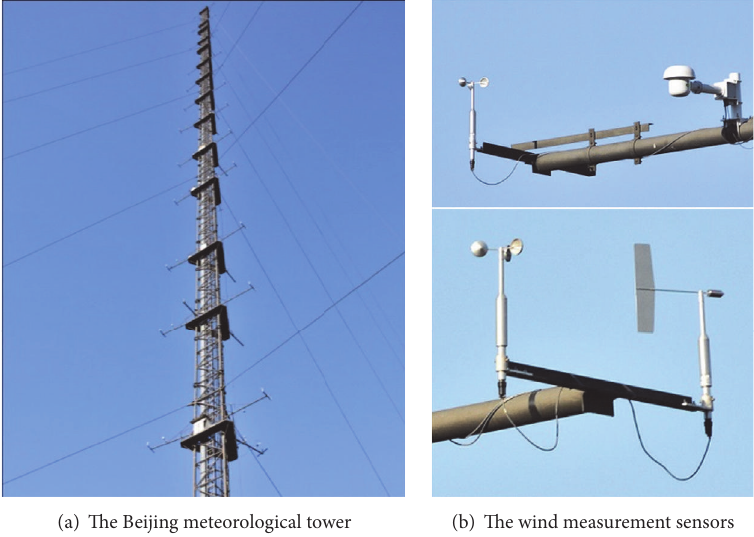
Figure 3: Photos of the Beijing meteorological tower and the sensors used for obtaining wind